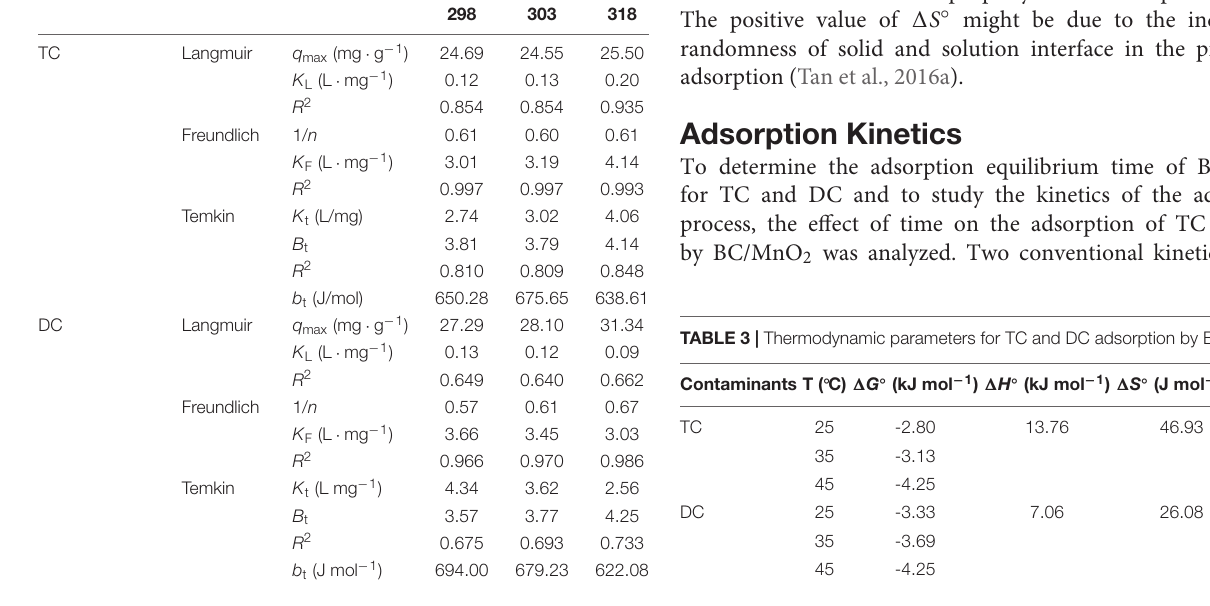
TABLE 2 | Model parameters and the corresponding correlation coefficients of isotherm models. Contaminants